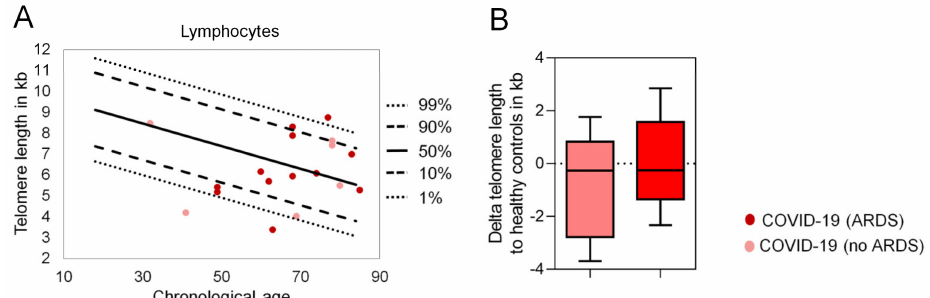
Figure 3. Telomere length analysis in COVID-19 patients. ( A ) Telomere lengths in kilo bases of 19 COVID-19 patients. Bovine thymocytes were used as internal controls. All measurements were carried out in triplicates. Lines indicate percentiles of the telomere lengths of 356 healthy con- trols. ( B ) Telomere length difference of no ARDS and ARDS patients to the respective age-adapted telomere